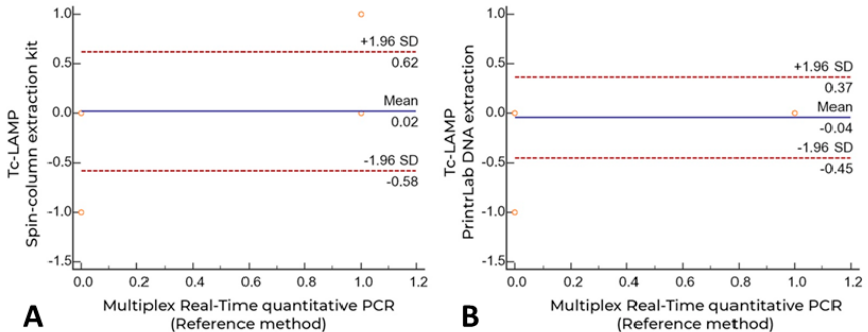
Figure 3. Agreement between multiplex real-time quantitative PCR and Tc-LAMP (Spin-column and PrintrLab DNA extractions) by Bland Altman plot analysis. ( A ) Manual extraction using the High Pure PCR Template Preparation Kit (Spin-column); ( B ) PrintrLab DNA extraction device version 4.0 using the MagMax DNA extraction kit.